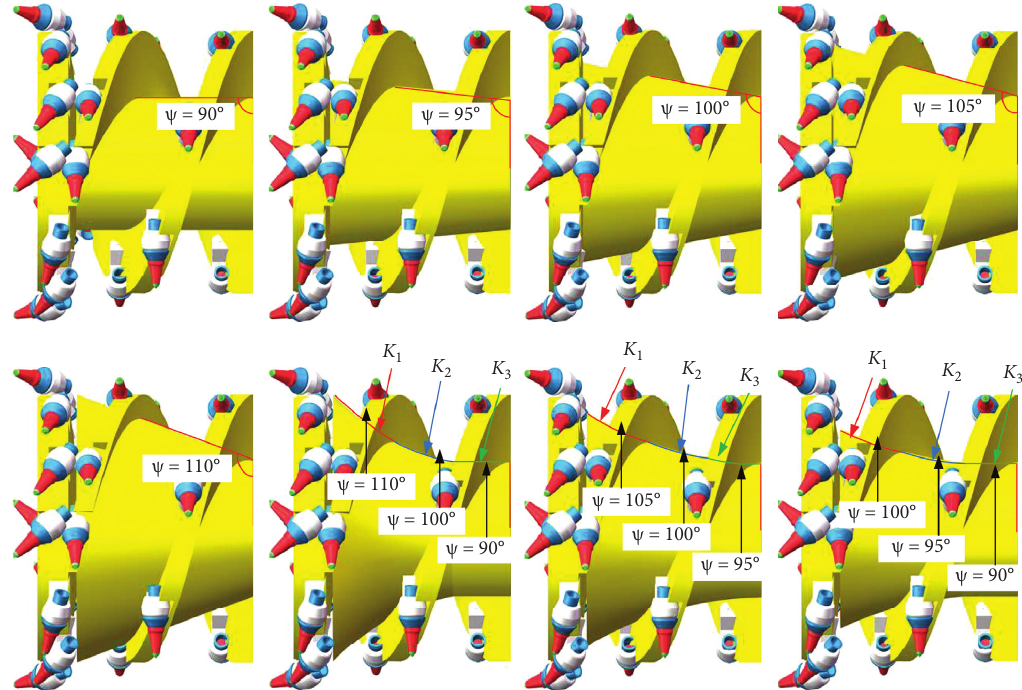
Figure 2: The drums with different forms and structures of the hub. Table 1: The structure parameters of the drum